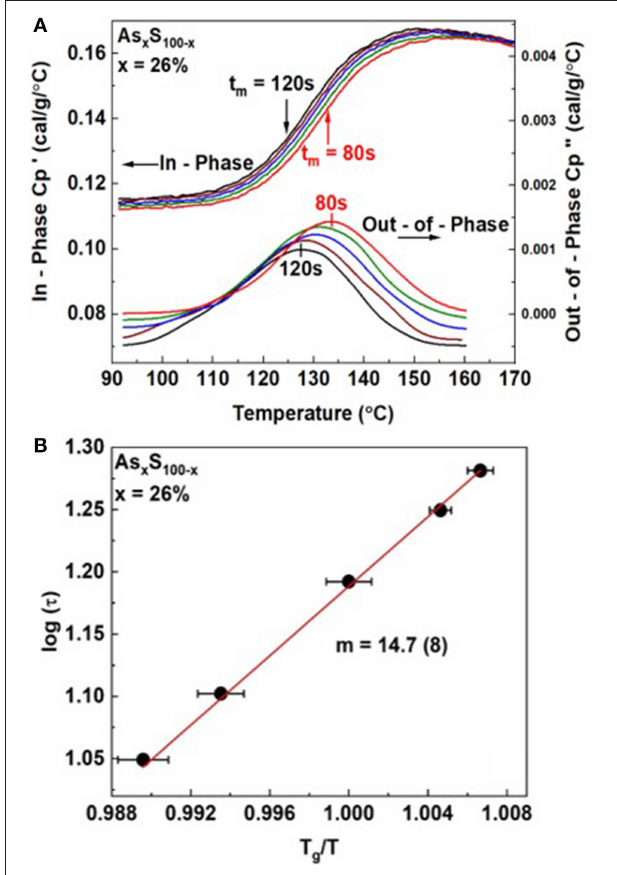
FIGURE 3 | (A) Observed variation in the in-phase C r p and out-of phase C i p term for an As 26 S 74 melt as a function of modulation frequency ω = 2 π /t m showing both terms to shift to higher T as ω is increased. (B) By establishing τ from the impressed ω , and measuring the T at which the peak in C i p occurs, one establishes the fragility index by plotting log τ against T g /T to deduce the slope from the semilog Arrhenius plot using equation 2. The deduced value of m =